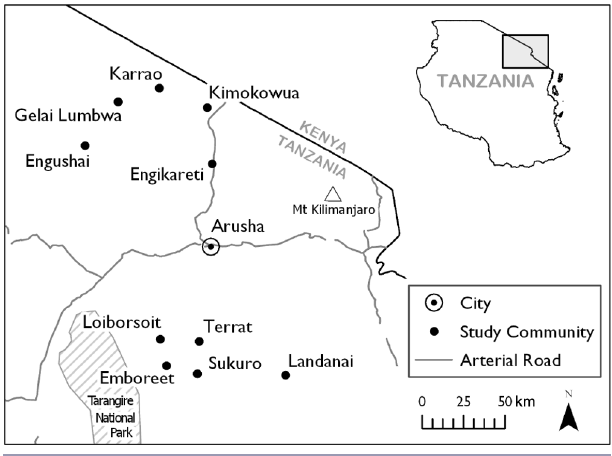
Fig. 1 . Map of the study area in northern Tanzania with study village centroids (Longido district villages north of Arusha; Simanjiro district villages south of